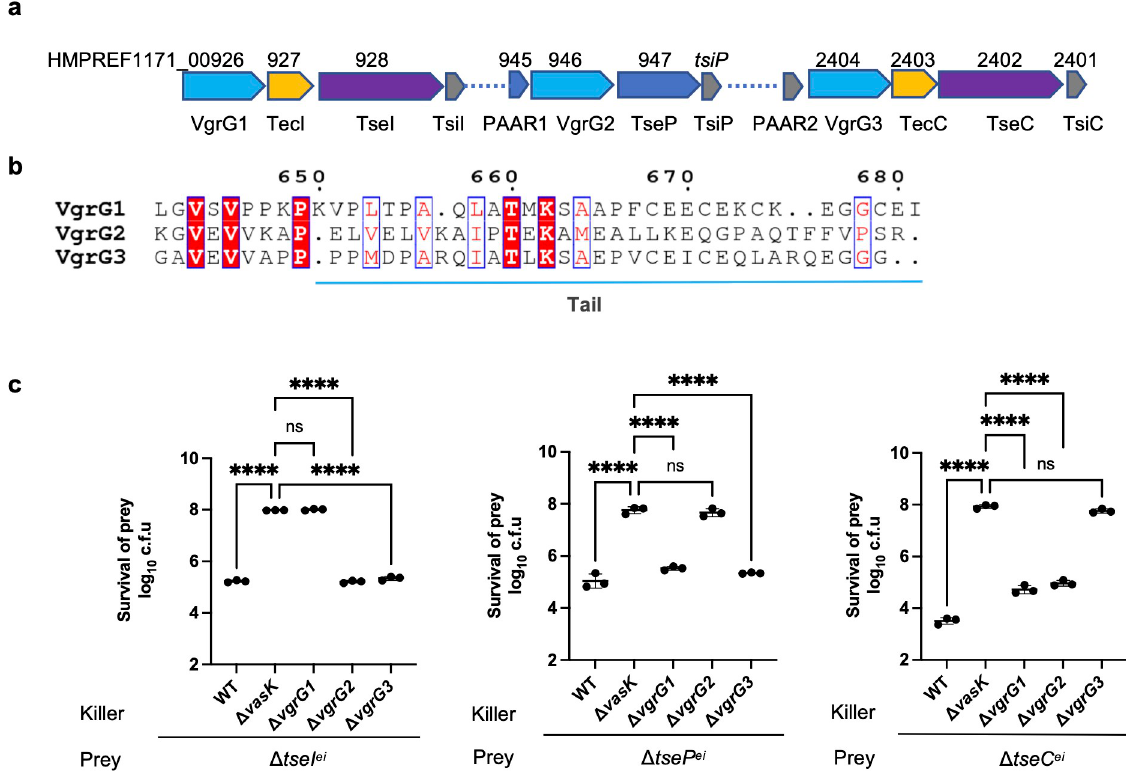
Fig 1. Specificity of VgrG-effector pairs in A . dhakensis SSU. A, Operon structures of the three VgrG-encoding clusters. Gene numbers and proteins are indicated. B, Alignment of VgrG sequences highlights the divergence at the C-terminal tail. Alignment was generated using COBALT and visualized using the ESPript server. Full sequence alignment is shown in Figure A in S1 Text. C, Competition assay of wild type (WT), the T6SS null Δ vasK mutant, and individual Δ vgrG mutants against effector-immunity deletion mutants. Survival of prey was quantified after co-incubation with the killer strains. Error bars indicate the mean +/- standard deviation of at least three biological replicates and statistical significance was calculated using one-way ANOVA analysis. ���� P < 0.0001, ns: not significant.